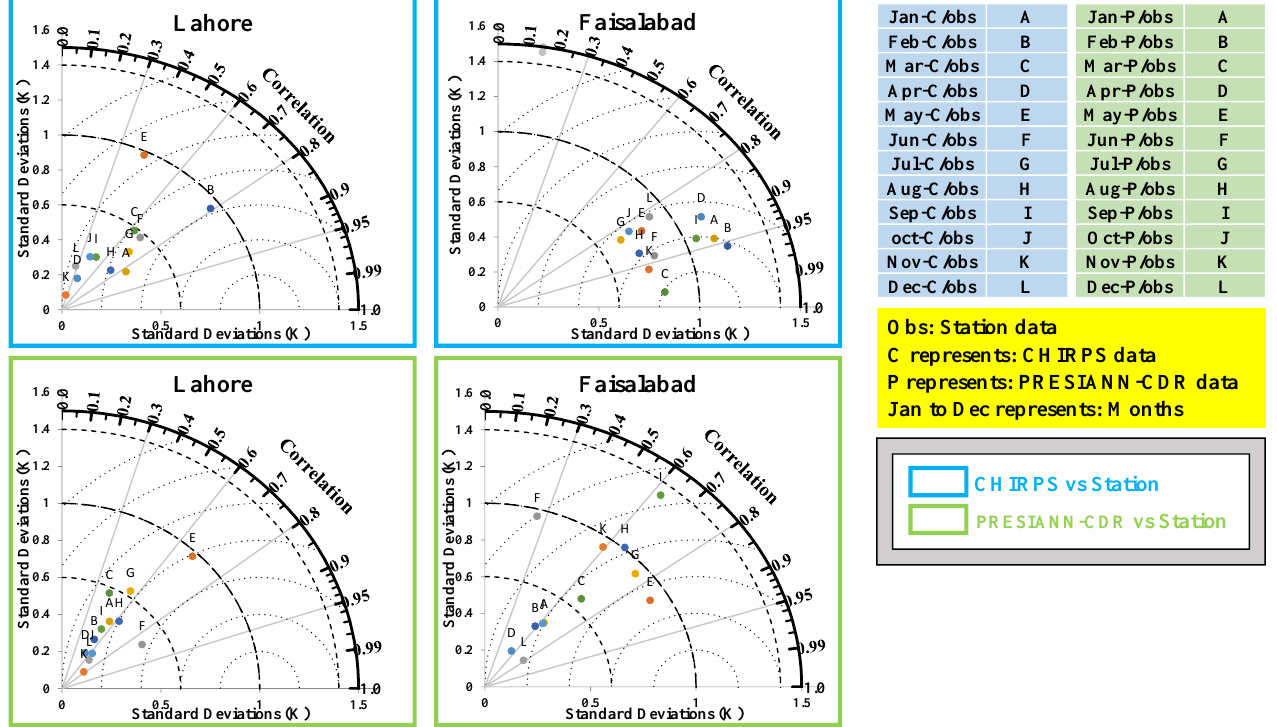
Figure 7. Taylor diagram exhibiting spatial association between station data and satellite data sets.